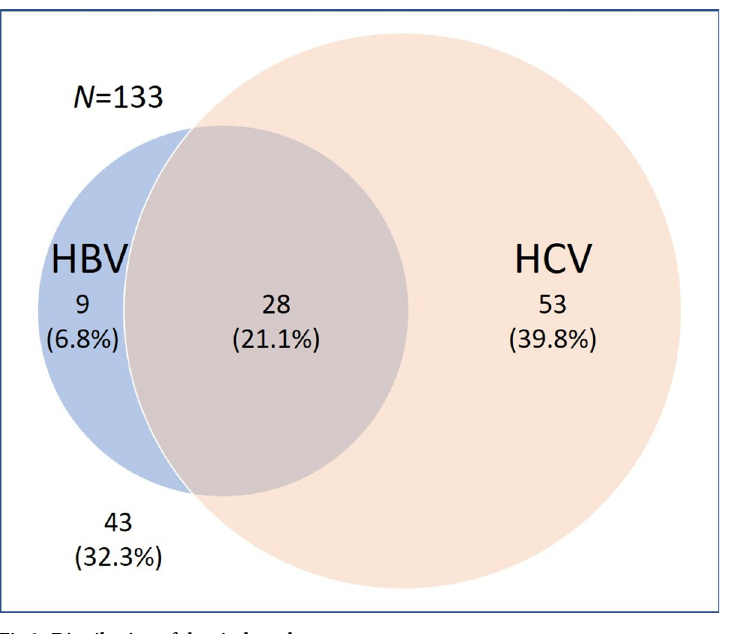
Fig 2. Distribution of the viral